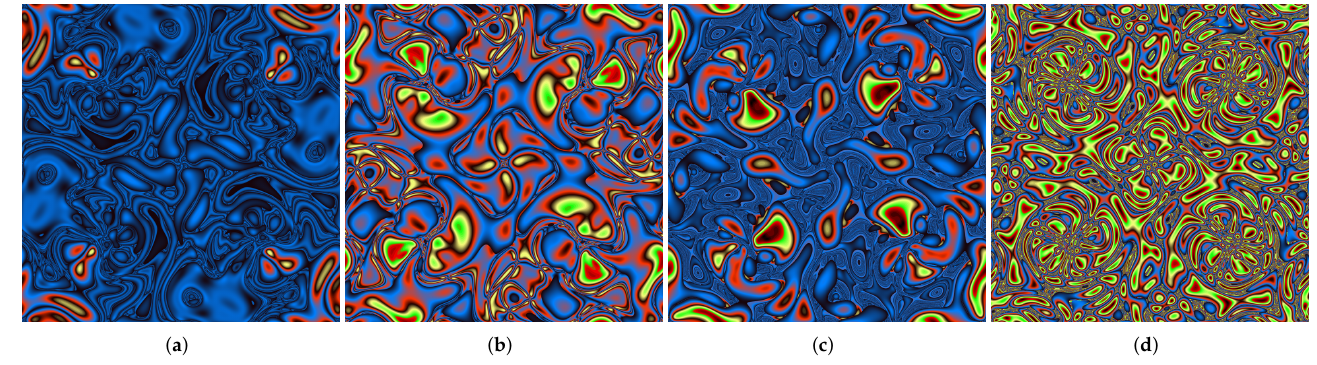
Figure 9. Patterns generated with function f with p4 symmetry, orbit traps from Figure 1c, and S-iteration with β = [ 0.5,0 ] T and varying α parameter. ( a ) α = [ 1.1,0.5 ] T ; ( b ) α = [ 1.1,0.8 ] T ;